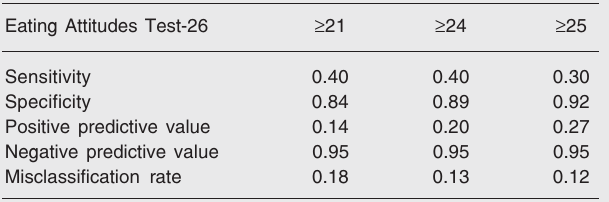
Table 4. Coefficients of validity of the Eating Attitude Test-26 at different cut-offs (N =